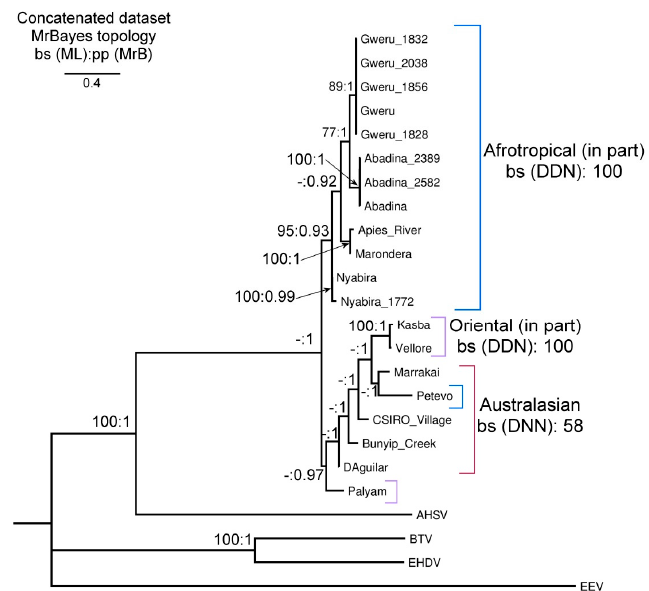
Figure 2. Phylogenetic tree for the concatenated dataset of the Palyam serogroup of orbiviruses used in this study. Bootstrap values from the Maximum Likelihood analysis were superimposed on the posterior probabilities gained from Bayesian analysis (bs: pp), bs values < 75 and pp values < 0.9 are not displayed and are represented by a “-“. The Afrotropical serotypes, excluding Petevo, formed a well-supported monophyletic clade (Figures 1 and 2, DDN: 100, MrB: 1). Within the clade, Apies River and Marondera were recovered